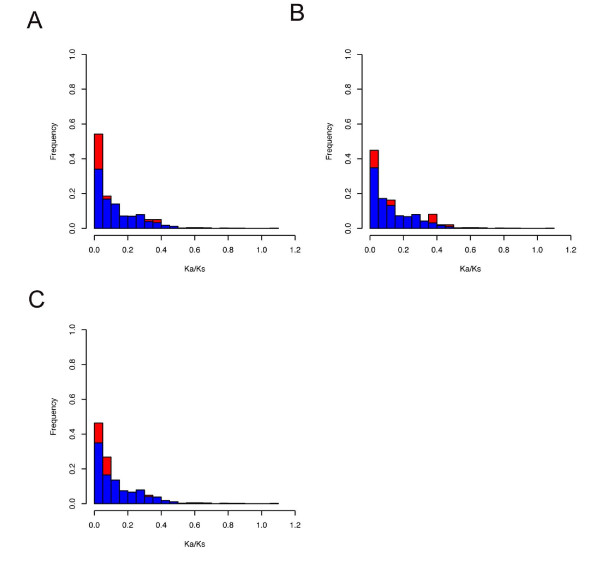
The distribution of Ka/Ks values (bear vs. dog) for hibernation-related genes (red color) and the rest of genes (blue color) in heart (A), liver (B), and skeletal muscle (C).